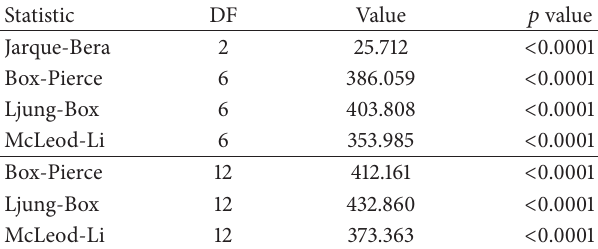
Table 2: Normality and white noise tests (RMP).